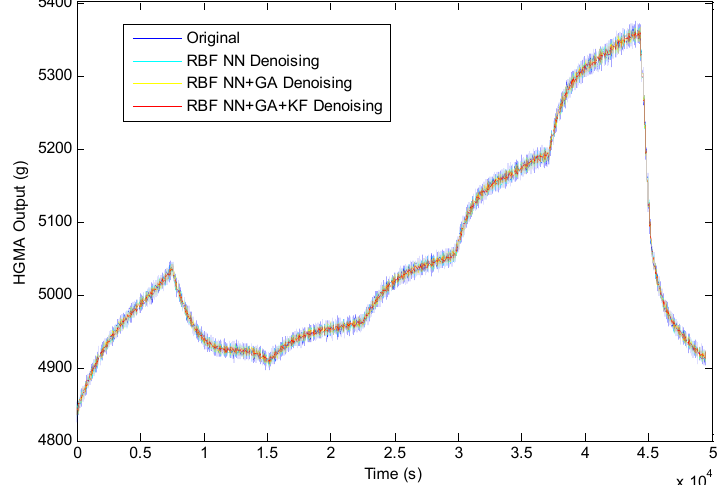
Figure 11. The three temperature energy models influence drift of the accelerometer.